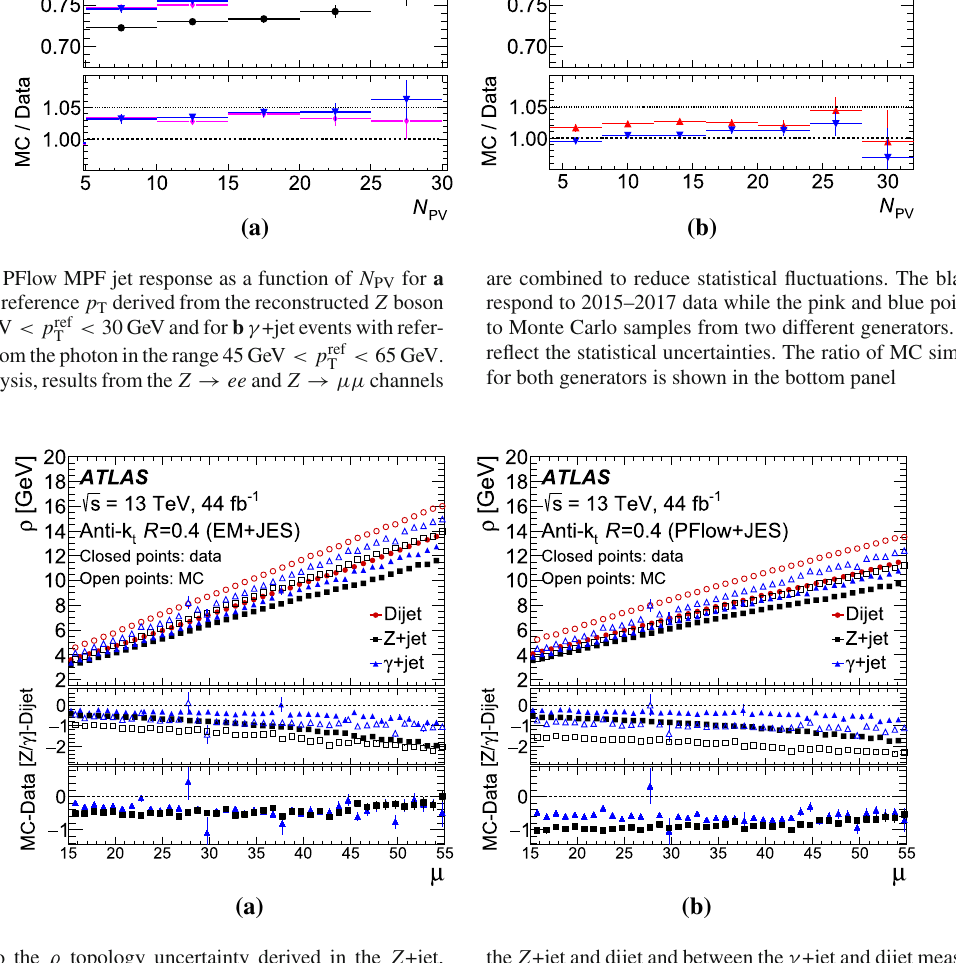
the Z +jet and dijet and between the γ +jet and dijet measurements. The lowermost panels show the difference between the data and MC simu- lation lines in the second panels: this defines the size of the topology uncertainty. The two plots show a EMtopo and b PFlow jets, illustrating why this uncertainty is larger for PFlow jets than for EMtopo